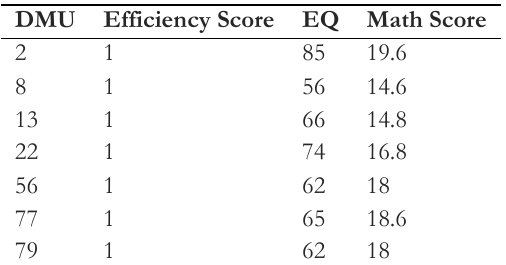
Table 4. Efficient units with EQ as input measure.